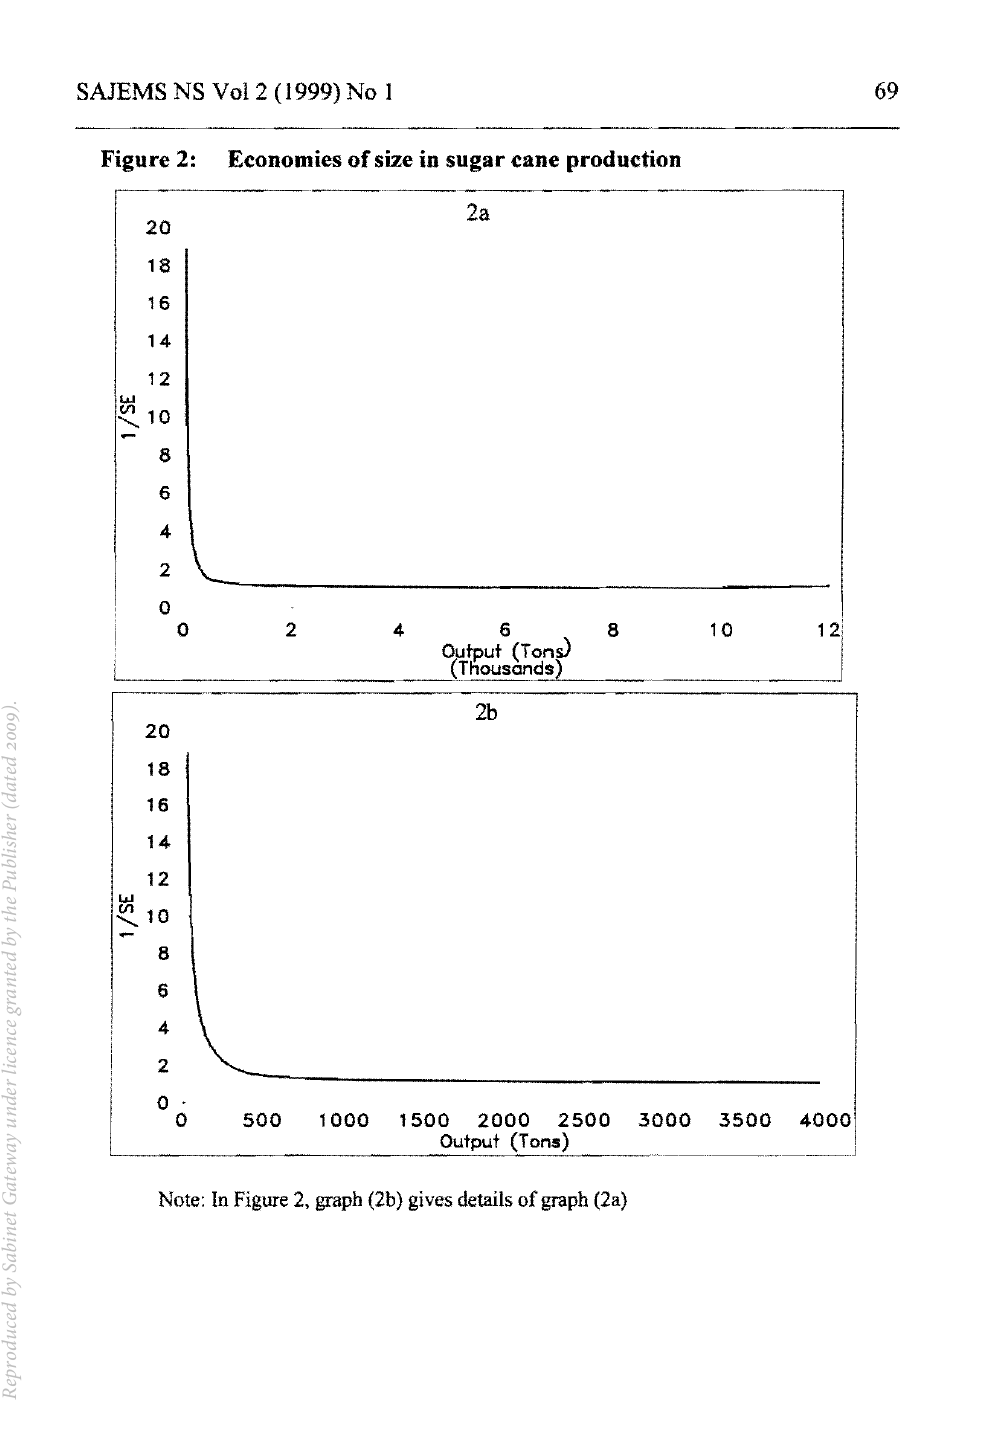
Figure 2: Economies of size in sugar cane